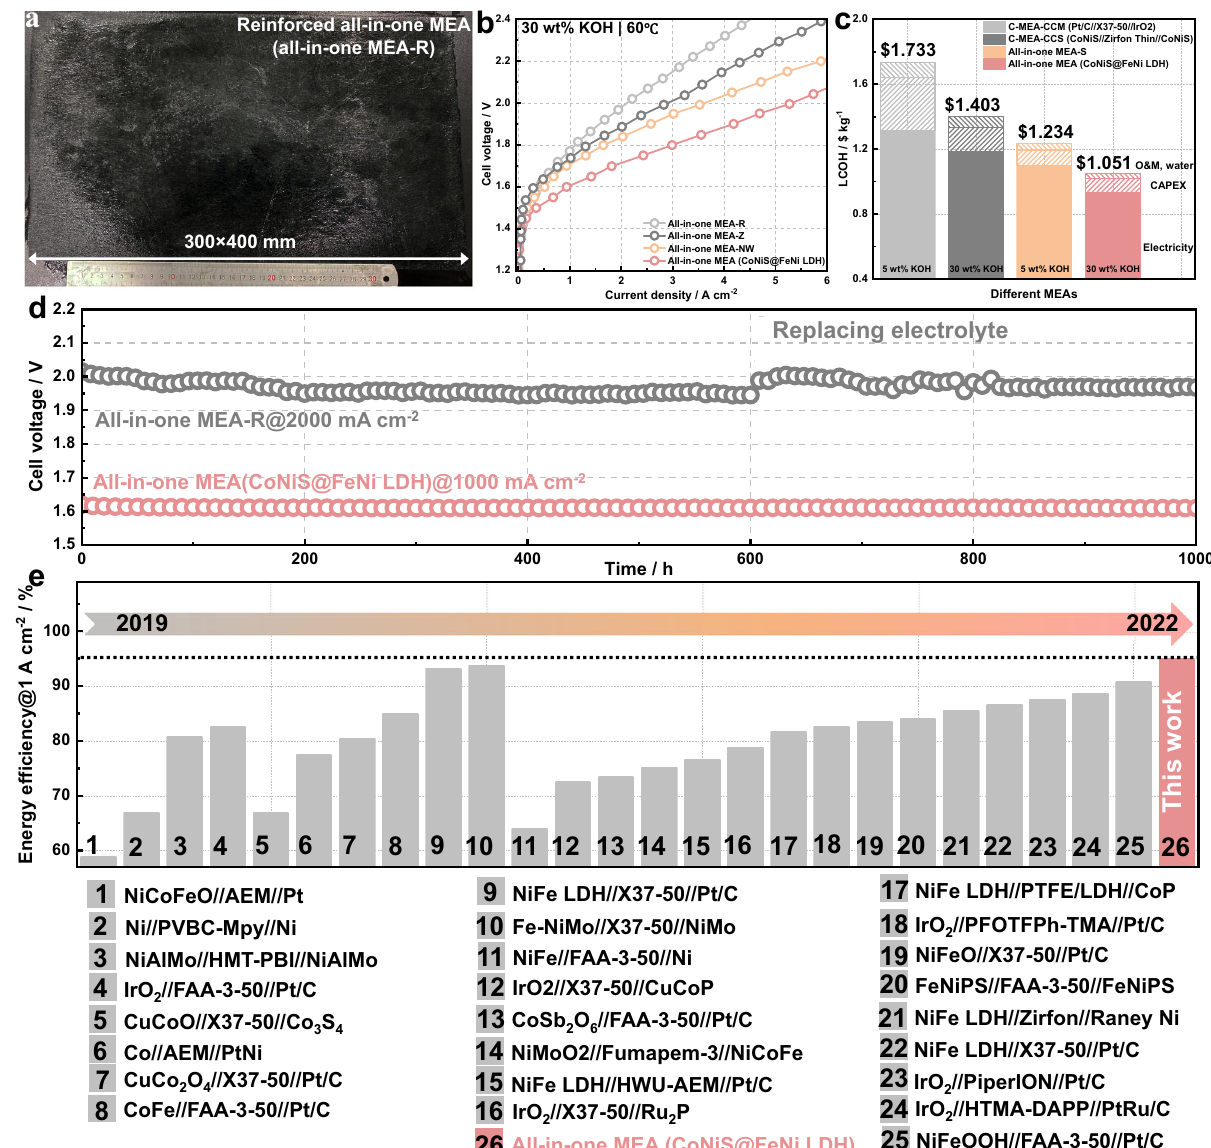
Fig. 6 | Generality ofthe oriented CL intergrowth strategy. a Photograph of the all-in-one MEA-R prepared. b Polarisation curves of the all-in-one MEA-R, all-in-one MEA-N and all-in-one MEA (CoNiS@FeNi LDH) in 30wt% KOH at 60°C. c LCOH of advanced alkaline water electrolysis using the C-MEA-CCM(Pt/C//X37-50//IrO 2 ),C- MEA-CCS (CoNiS//Zirfon Thin//CoNiS) and all-in-one MEA-S. d Durability cell